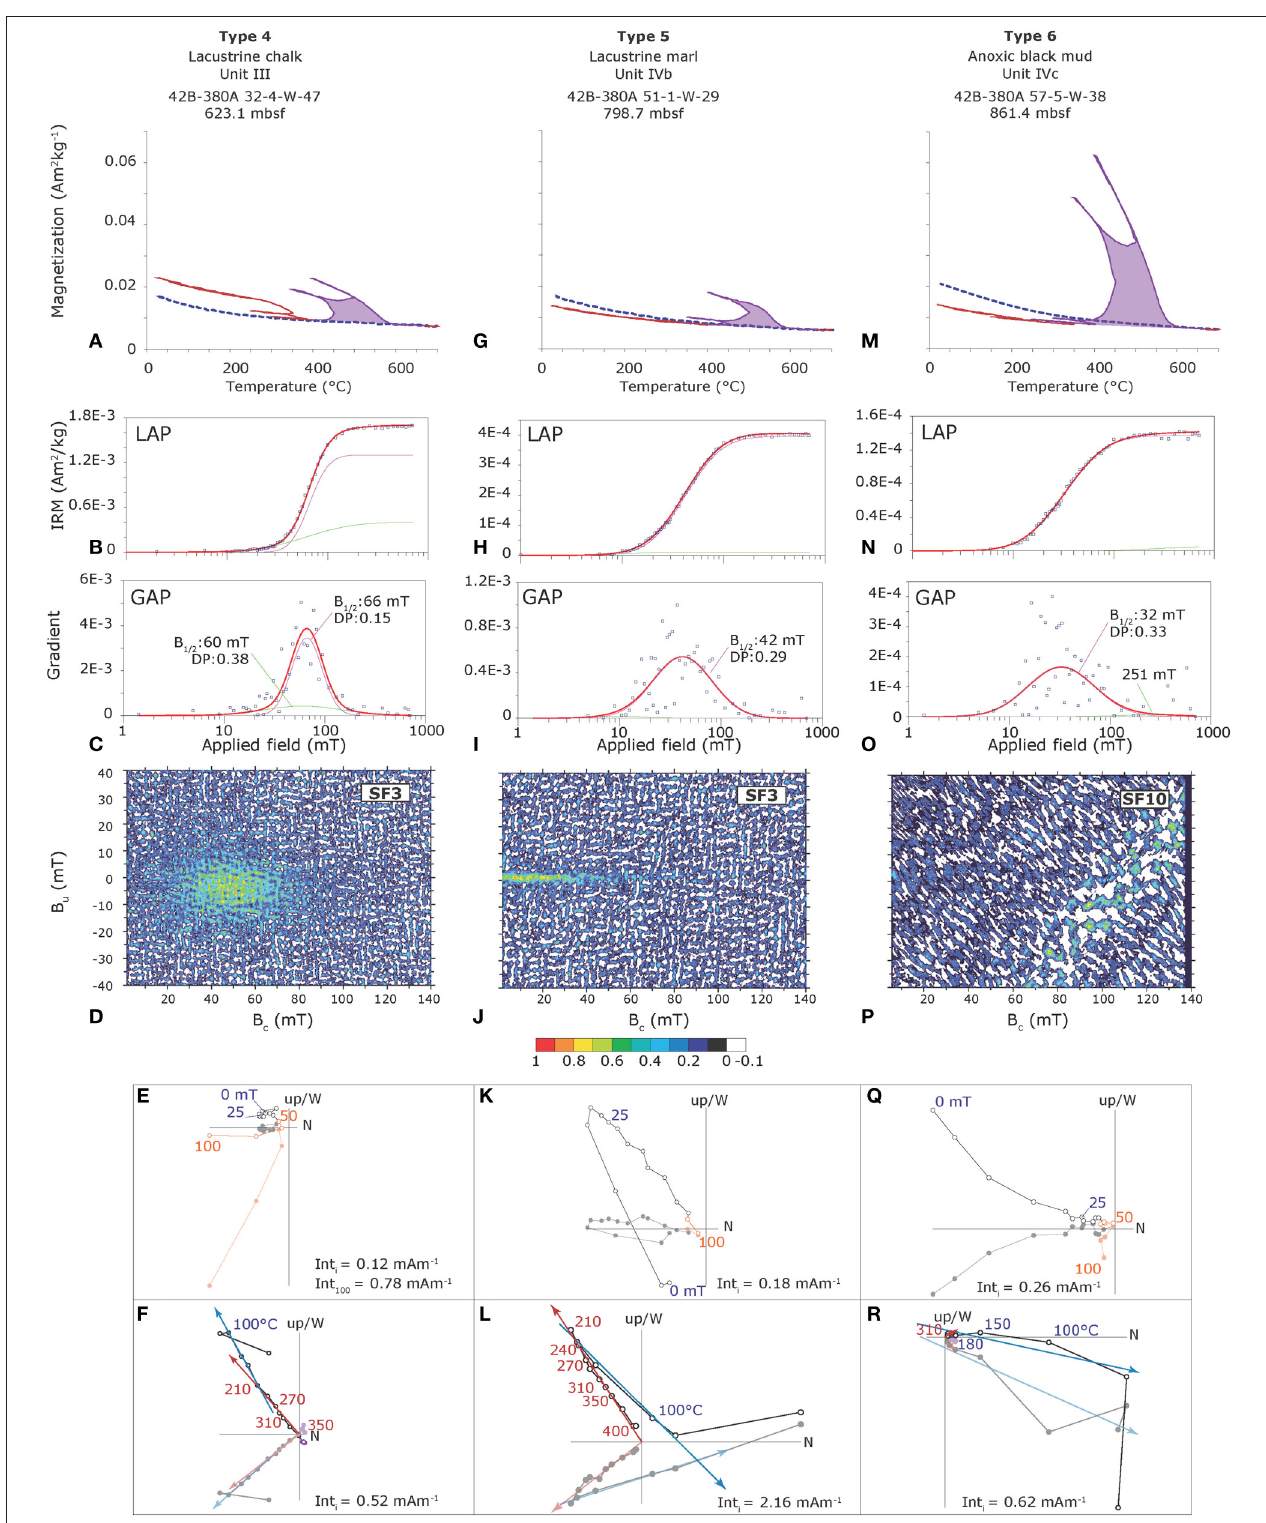
FIGURE 3 | Rock-magnetic properties and demagnetization diagrams for Types 4–6. Panels are similar to Figure 2 .